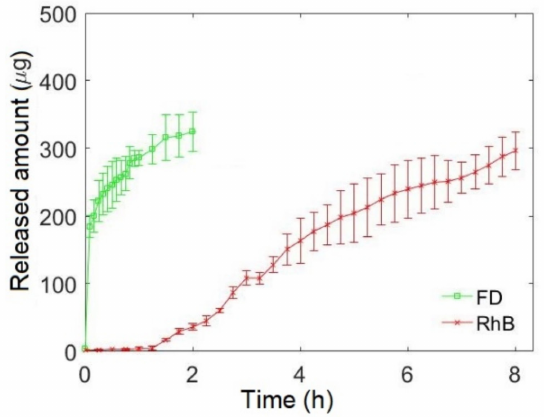
Figure 4. Biphasic bidrug release of FD from R 0 and RhB from R 2